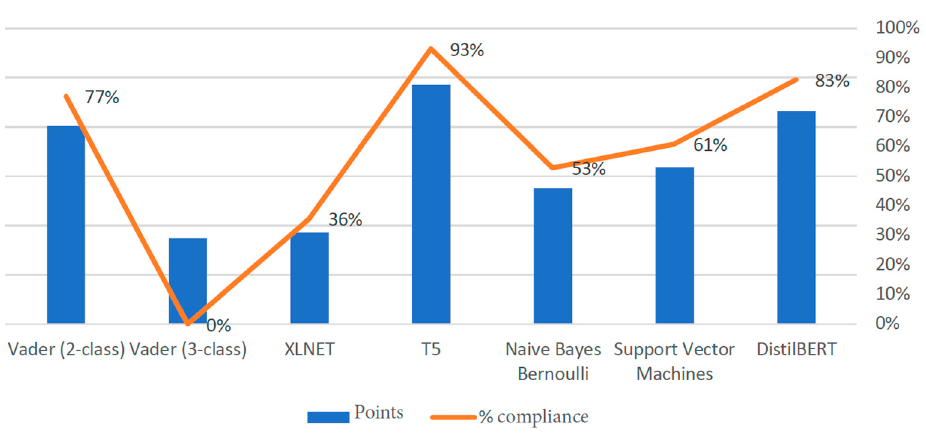
Figure 4. Test of sentiment test methods for English comments.